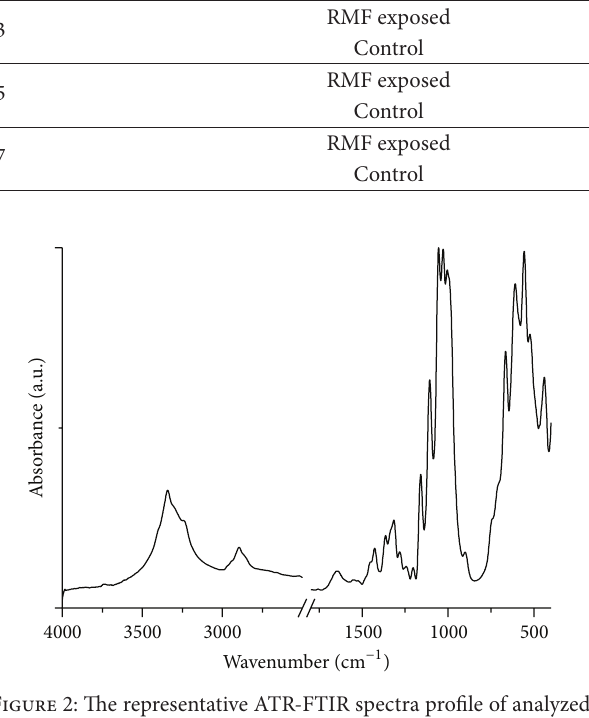
Table 1: The BC crystallinity index from ATR-FTIR spectra and % of 𝐼 𝛽 allomorph form content. Days of BC synthesis